Question: In a single sentence, describe what this figure presents.
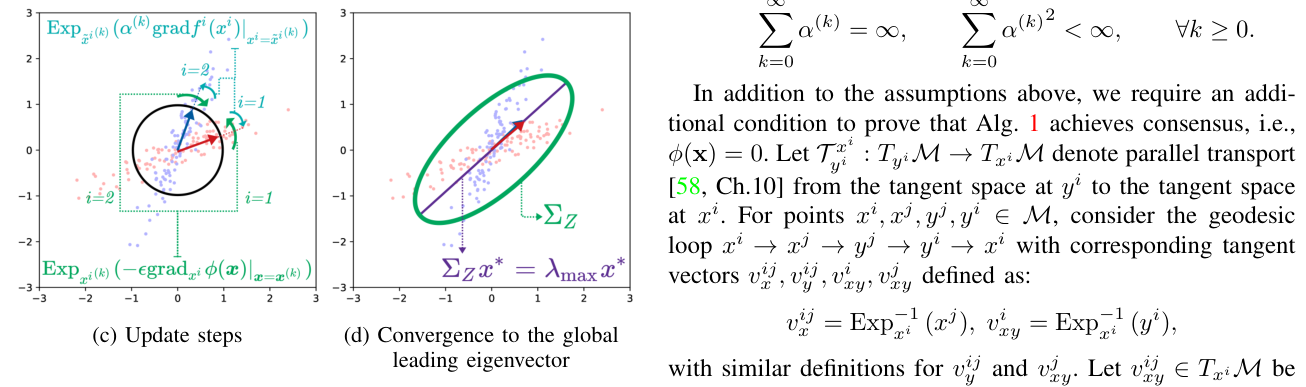
Answer: Application of Alg. 1 to the leading eigenvector problem. (a) Data distribution Z = [Z⊤ 1 Z⊤ 2 ]⊤, where Z1 and Z2 are separately known to agent 1 and agent 2. (b) State initialization, limited to the unit circle S1 since we are only interested in eigenvector directions. (c) Consensus and local objective function updates, shown in green and teal arcs, respectively. The exponential mapping of S1 maintains the manifold structure of the states throughout the update steps. (d) Level-set of the covariance matrix of the global data Z is shown, alongside its leading eigenvector x∗.